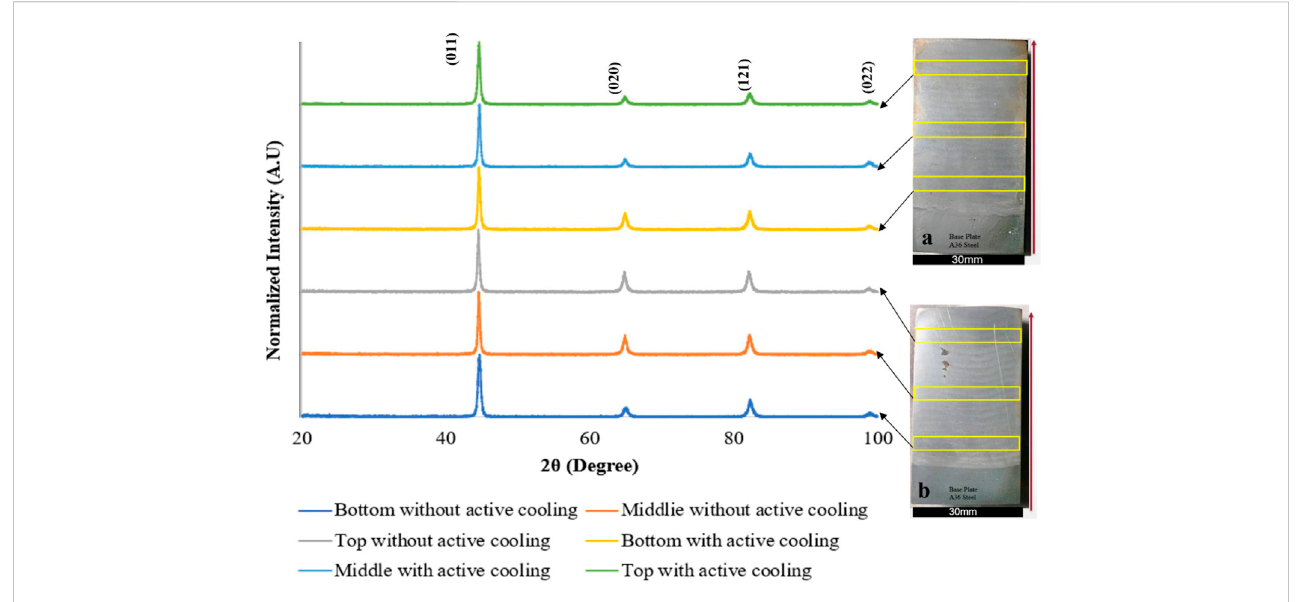
FIGURE 7 X-ray diffraction spectrums of the cylindrical samples at three regions of interest for fabrication — (A) with active cooling and (B) without active